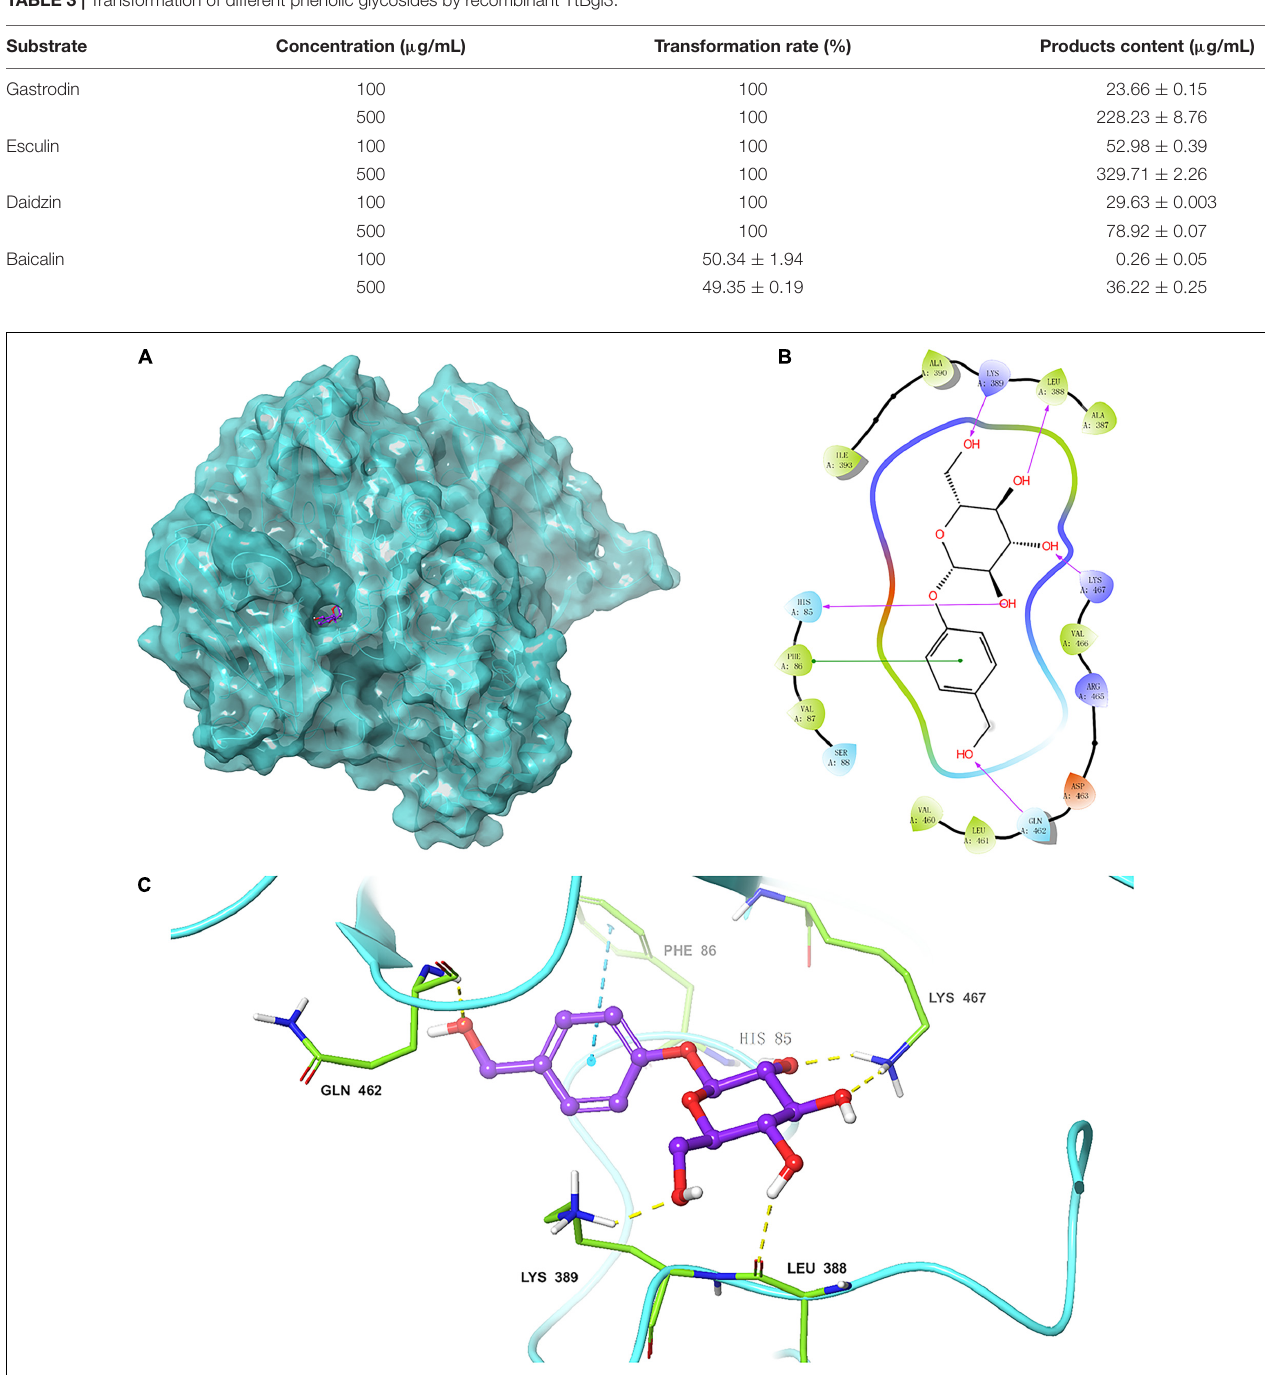
FIGURE 7 | (A) Homologous model of TtBgl3 bound with gastrodin (1). The crystal structure of TtBgl3 (PDB accession number 3abz.1.A) was used as a template for homology modeling. (B) Residues of TtBgl3 interact with gastrodin (1). The hydrogen bond is shown as purple arrow. (C) Surface representation of the hydrophobic region of the TtBgl3 catalytic pocket. The hydrogen bond is shown by yellow dashed